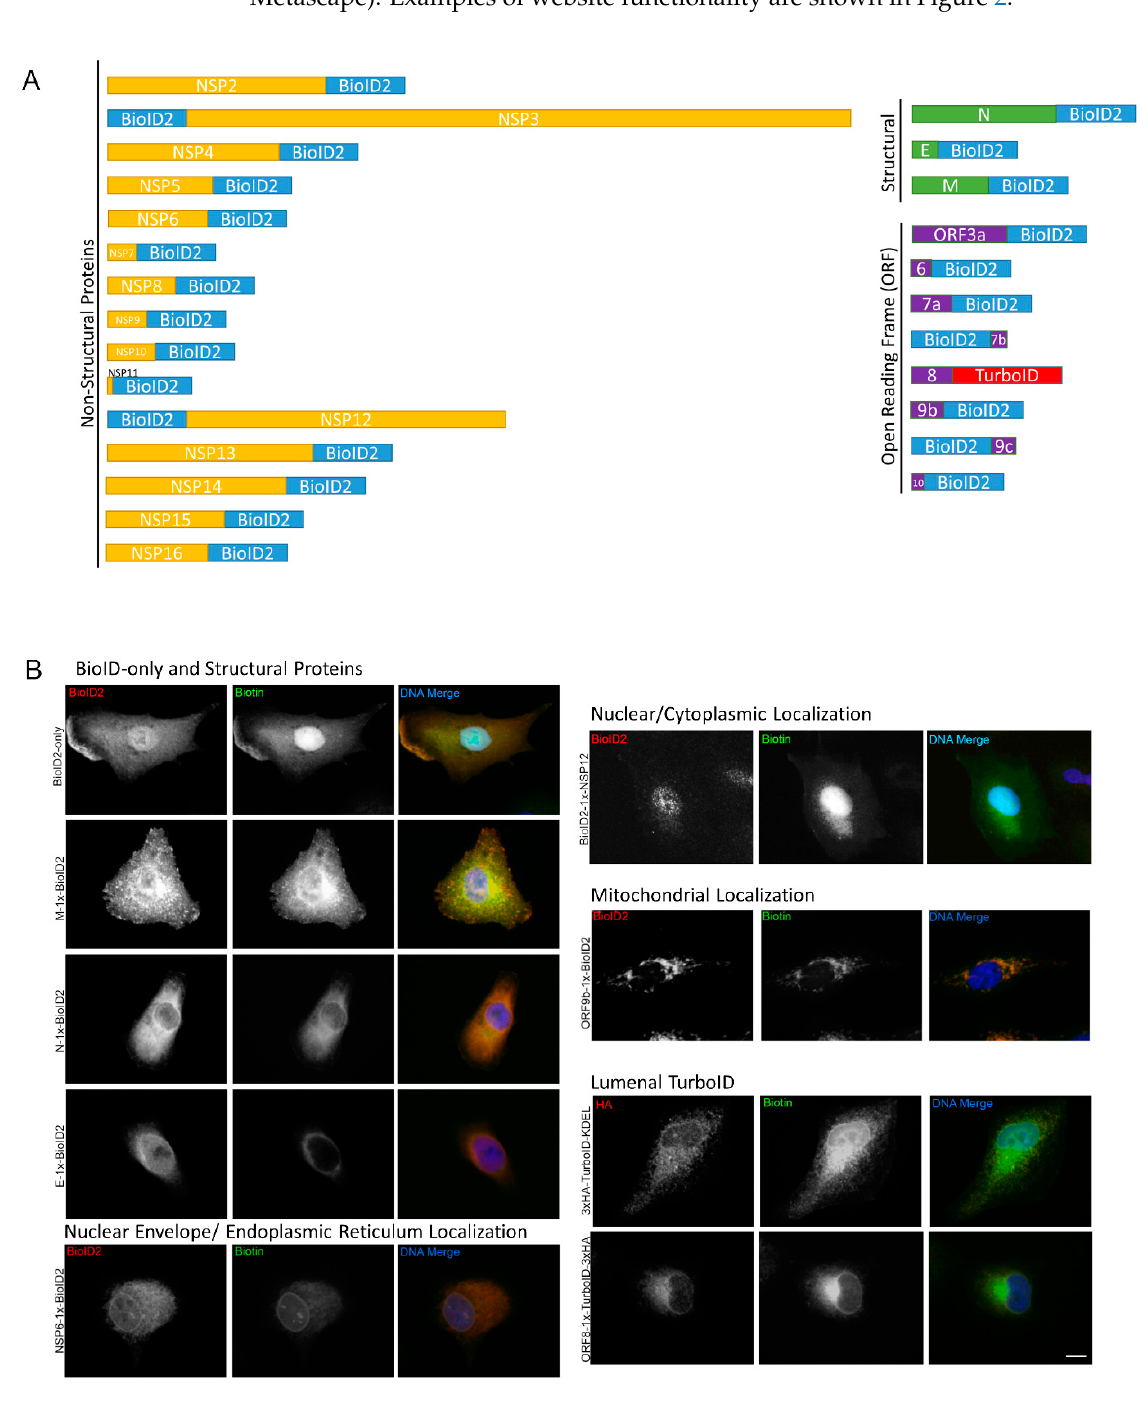
Figure 1. BioID2-viral fusion protein expression in A549 cells. ( A ) Viral proteins were fused to either the N- or C-terminus of the BioID2 promiscuous biotin ligase. The schematic shows the orientation of NSPs (yellow), structural proteins (green), and ORF proteins (purple) fused to BioID2 to scale. ( B ) A549 human lung cells stably expressing BioID2-fusion proteins were assessed for fusion-protein expression and localization (red) and promiscuous biotinylation (green) following the addition of exogenous biotin. Scale bar 10 μ m.